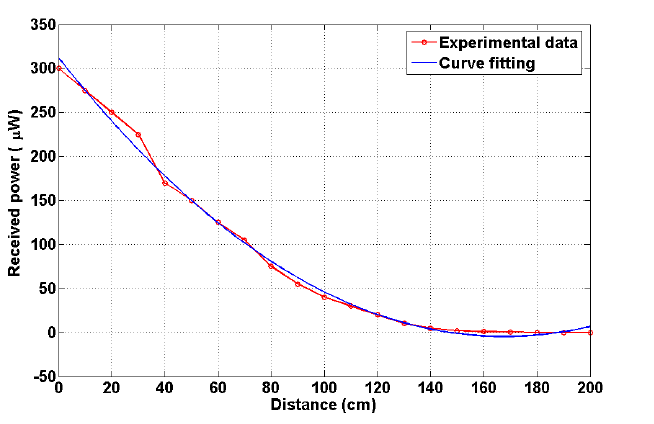
Figure 7. Channel path loss characteristics.